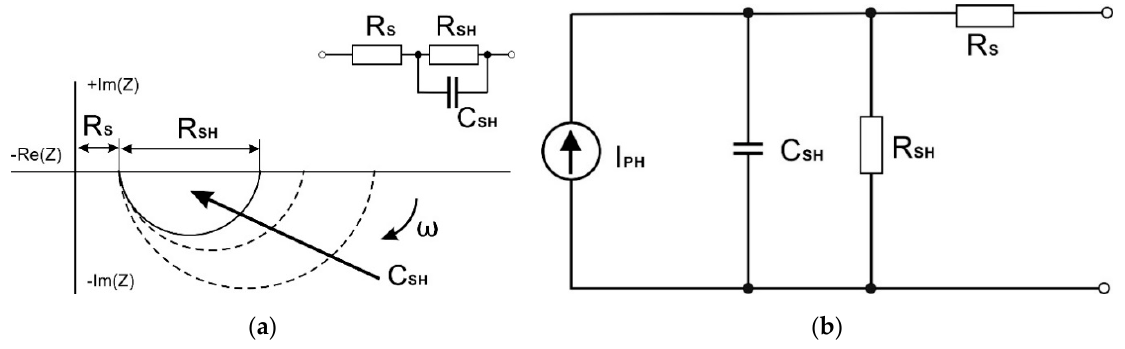
Figure 4. ( a ) Cole-Cole diagram of PV cell (module). ( b ) Dynamic model of the PV cell.